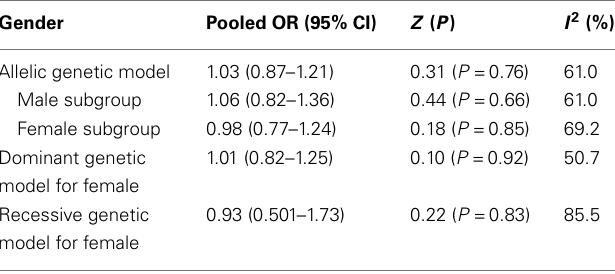
Table 1 | Summary of meta-analysis of association of ACE2 G8790A gene polymorphism and EH risk in the Chinese population.